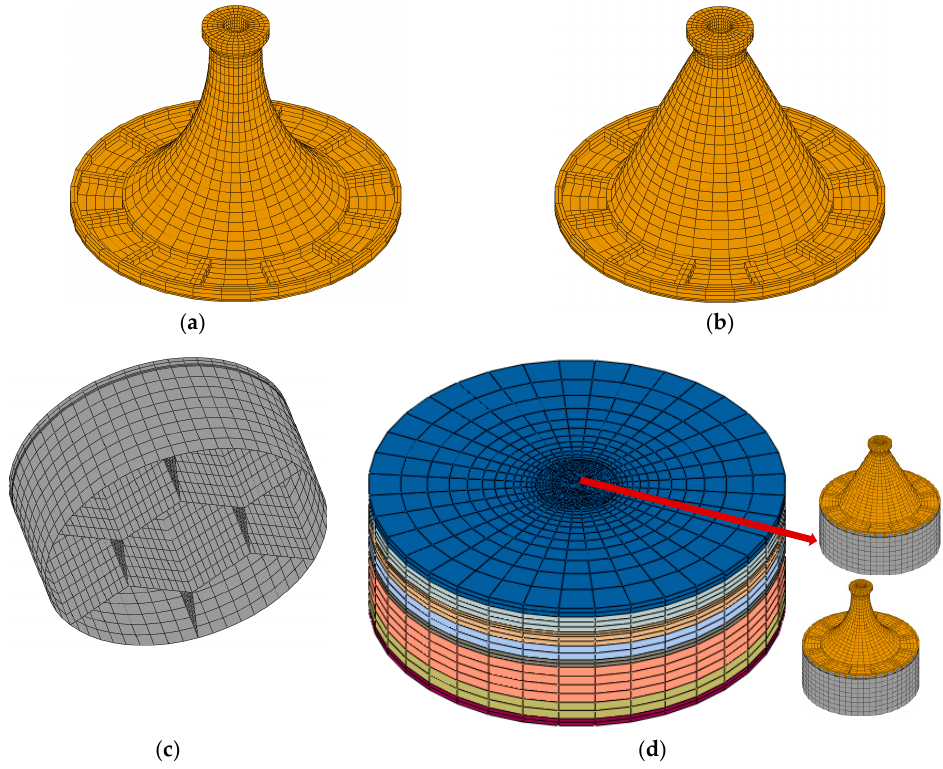
Figure 2. ABAQUS computation model: ( a ) Arc transmission section; ( b ) Line transmission part; ( c ) Bucket with subdivision plates; ( d ) Soil and foundation model.